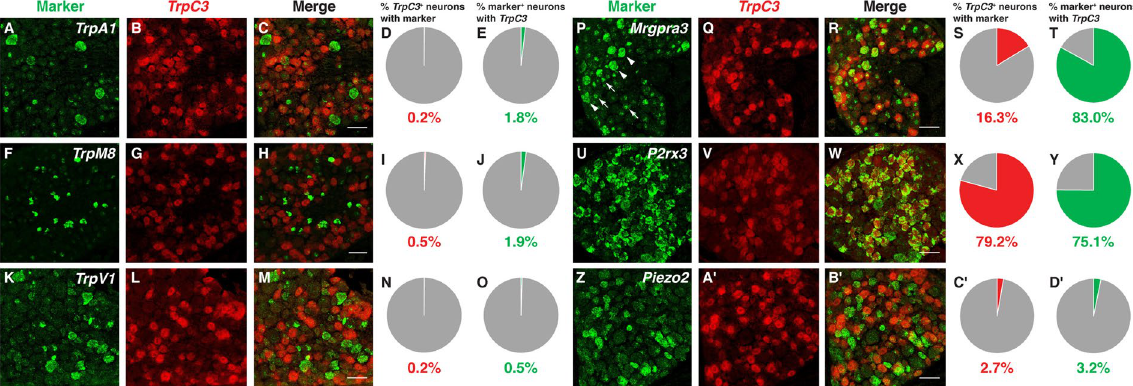
Figure 3. Expression of TrpC3 in DRG neurons with regard to other channels and receptors involved in somatosensation. ( A–D ’) Double fluorescent in situ hybridization for TrpC3 and TrpA1 ( A – E ), TrpM8 ( F – J ), TrpV1 ( K – O ), MrgprA3 ( P – T ), P2rx3 ( U – Y ), and Piezo2 ( Z – D’ ), along with percentage overlap quantification, in P21 WT mouse DRG thoracic sections. Few TrpC3 + DRG neurons express other TRP channel genes, as well as MrgprA3 and Piezo2 (although most MrgprA3 neurons express TrpC3 ). However, TrpC3 overlaps highly with P2rx3 , a receptor for ATP. In some FISH, there is green nuclear background (white arrows), which can be differentiated from real cytosolic signals (white arrowheads). N = 3 mice. Scale bar = 50 μ